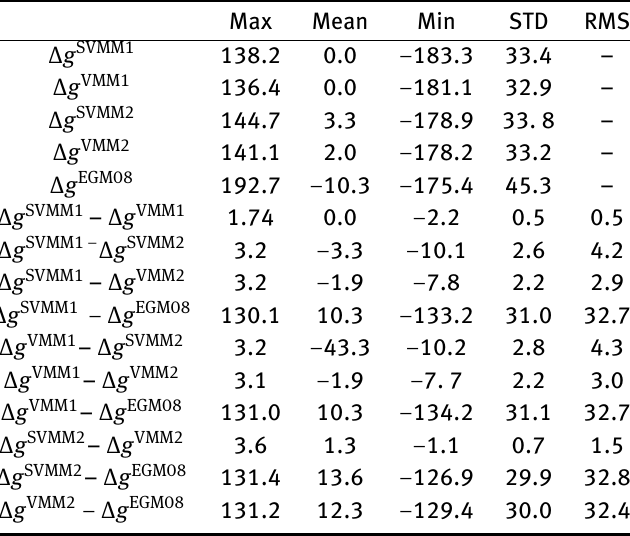
Table 2: Statistics of generated gravity anomalies from the crustal models and their differences. ∆ g SVMM1 from SVMM and SFLEX, ∆ g